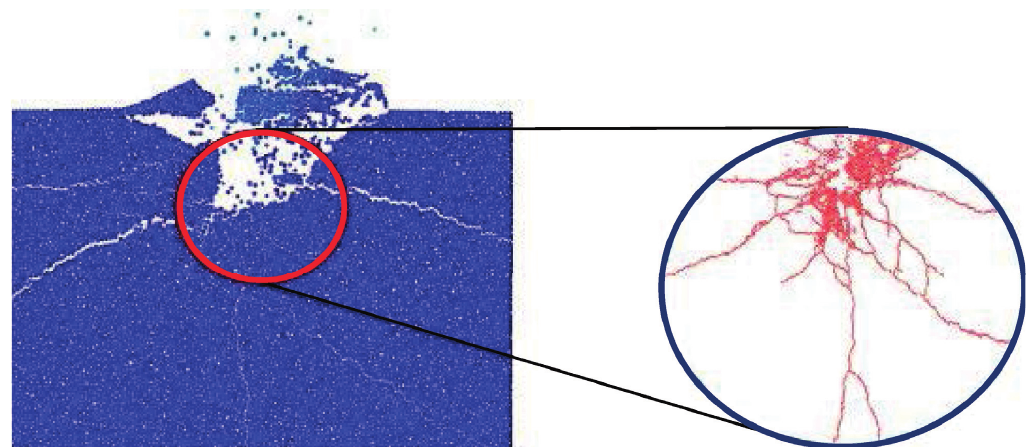
Figure 9: Cylindrical charge blasting crater and rock cracks.